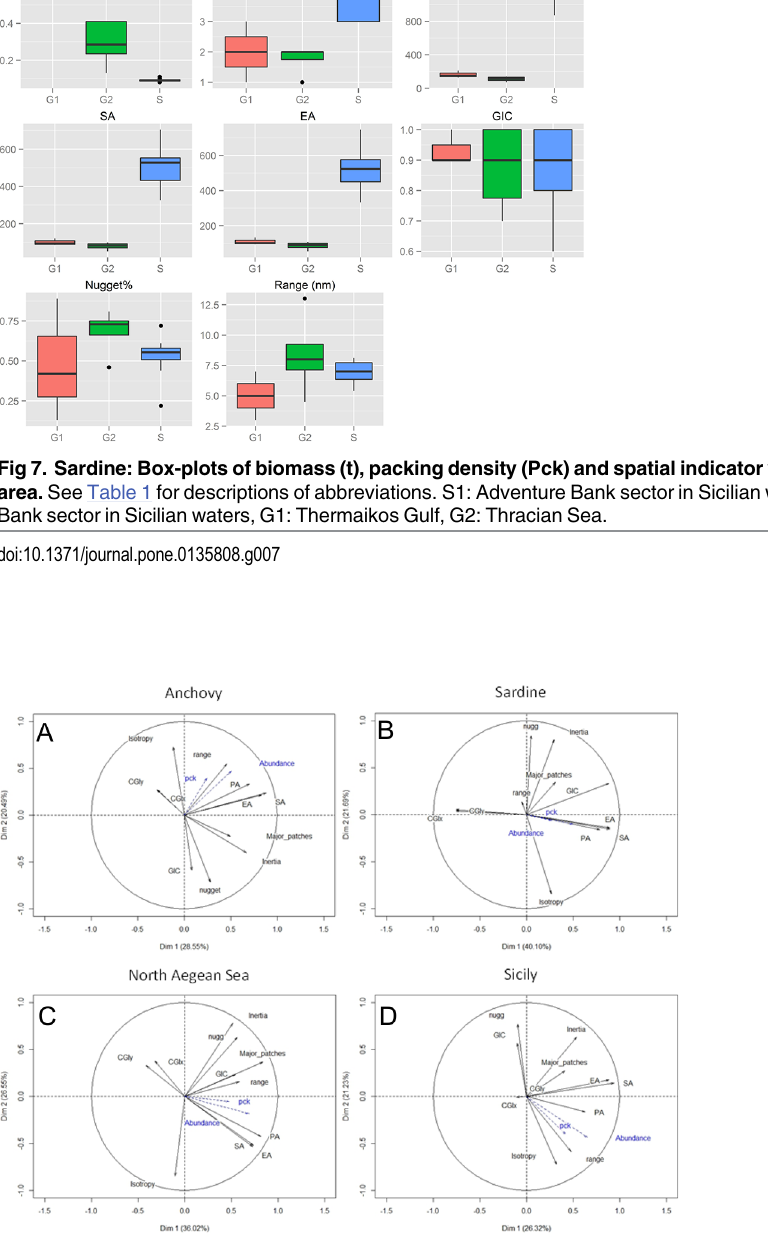
Fig 8. PCA biplots for (A) anchovy (B) sardine (C) North Aegean Sea and (D) Strait of Sicily. Active variables (spatial indicators) are shown in black. Descriptions of the spatial indicators are given in Table 1. Supplementary variables (biomass and packing density (Pck)) are shown in